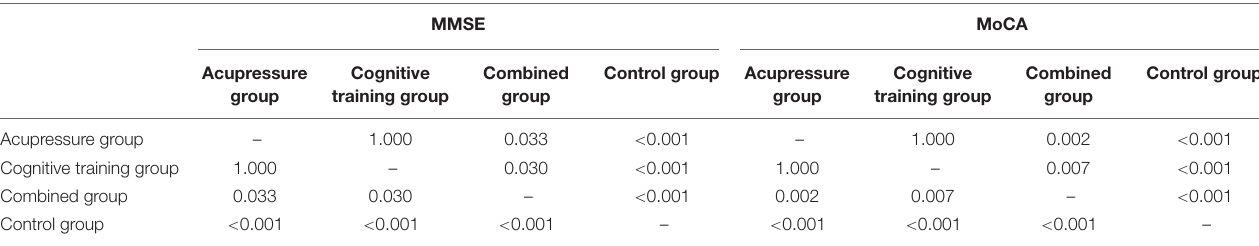
TABLE 5 | Pairwise comparisons of MMSE and MoCA scores among groups ( p